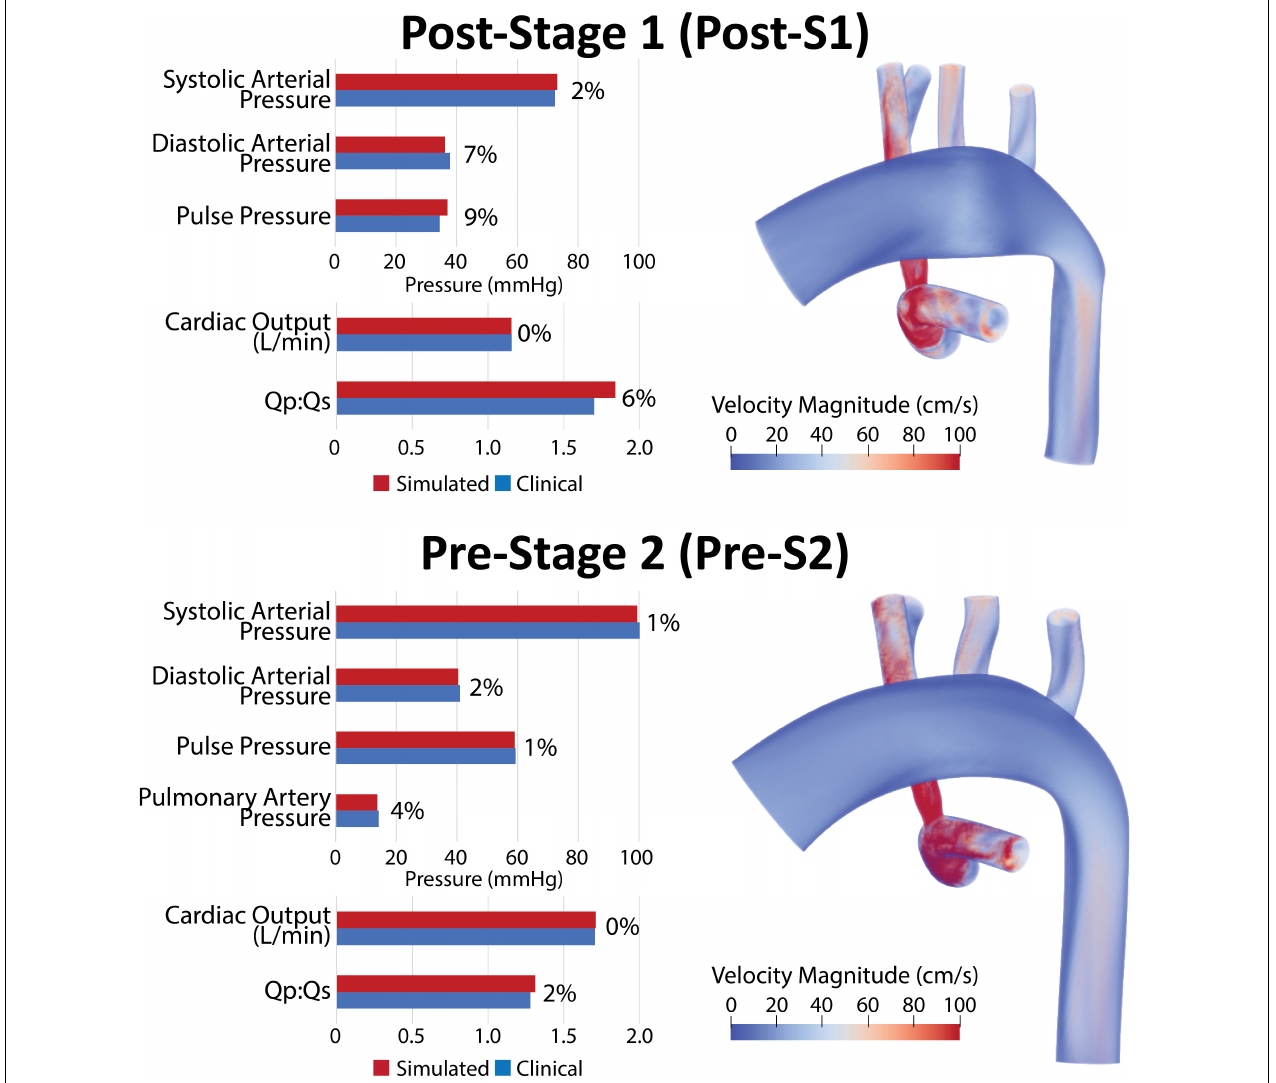
FIGURE 5 | Left: Comparison of simulated results (red) and literature-based clinical data (blue) of hemodynamic indices for post-S1 and pre-S2 models. All indices were matched within 10% of literature values. Right: Volume renders of FSI simulations velocity maps.